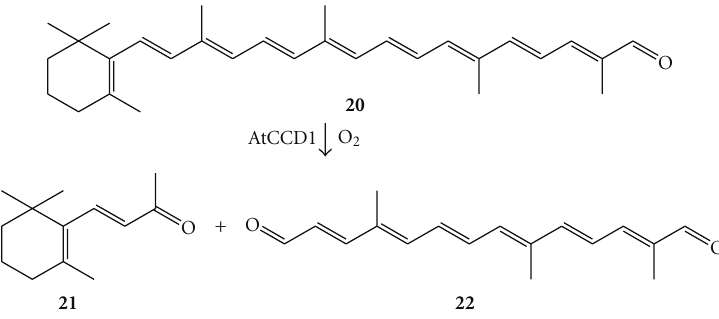
site may favour one mechanism over the other or the